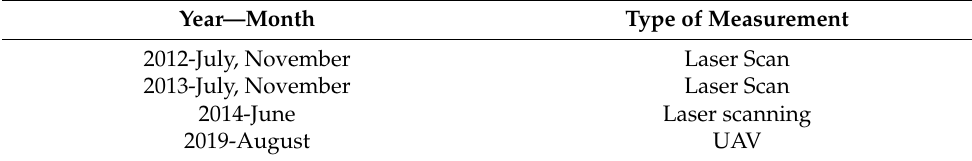
Table 2. Dates and data acquisition techniques for Site 1.